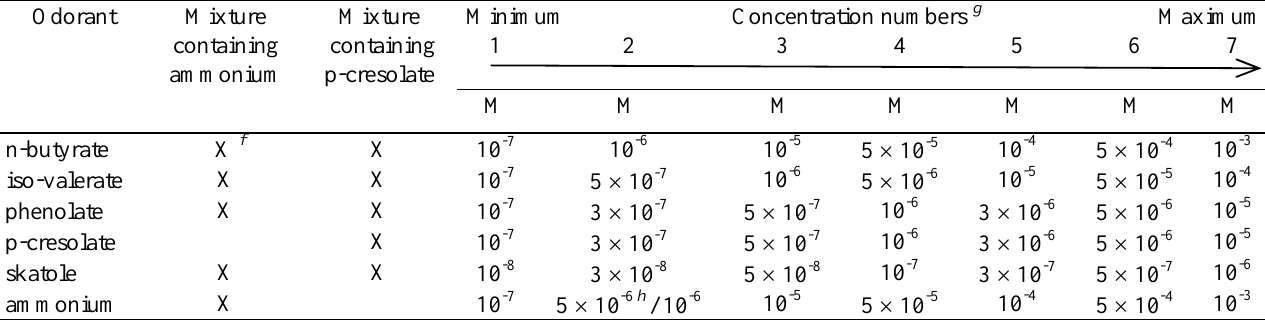
Table 3. Mixture of odorants and concentration intervals of key odorants. Odorant Minimum Concentration numbers g